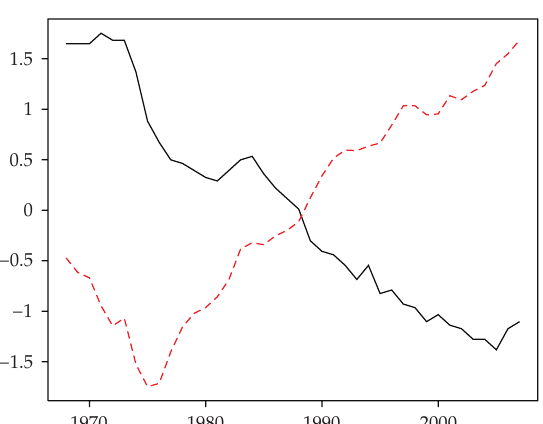
Figure 6: Plots of standardized total fertility rate and female labor force participation rate for women aged 15 to 49 in Japan, 1968–2007. The solid line represents standardized TRF; the dotted lines are standardized